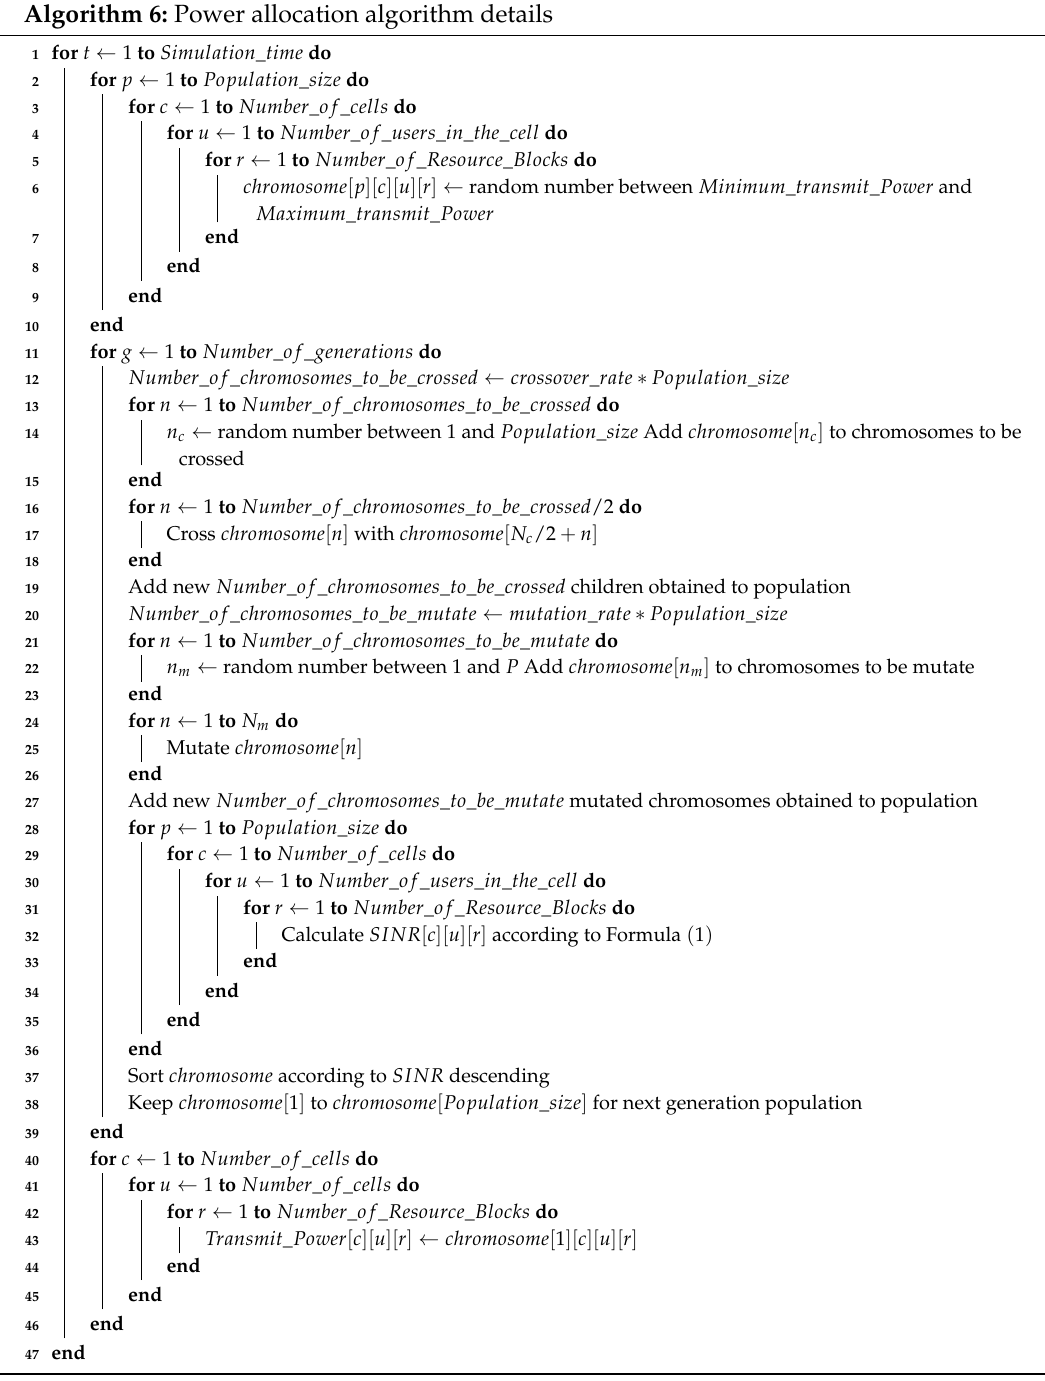
Algorithm 6: Power allocation algorithm